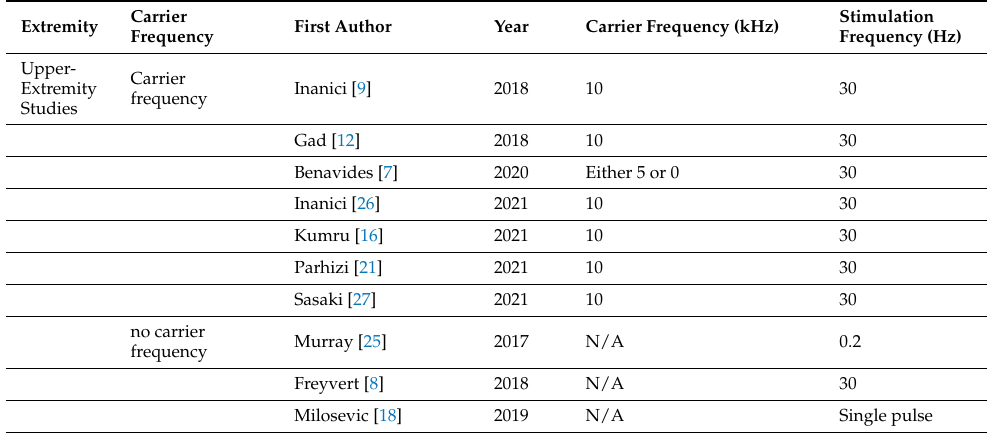
Table 3. Stimulation frequency pattern in the studies that applied or did not apply carrier